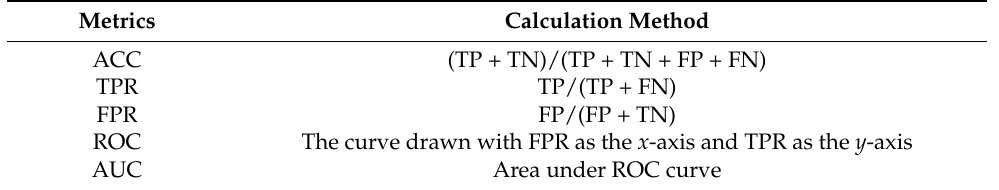
Table 4. Detailed evaluation